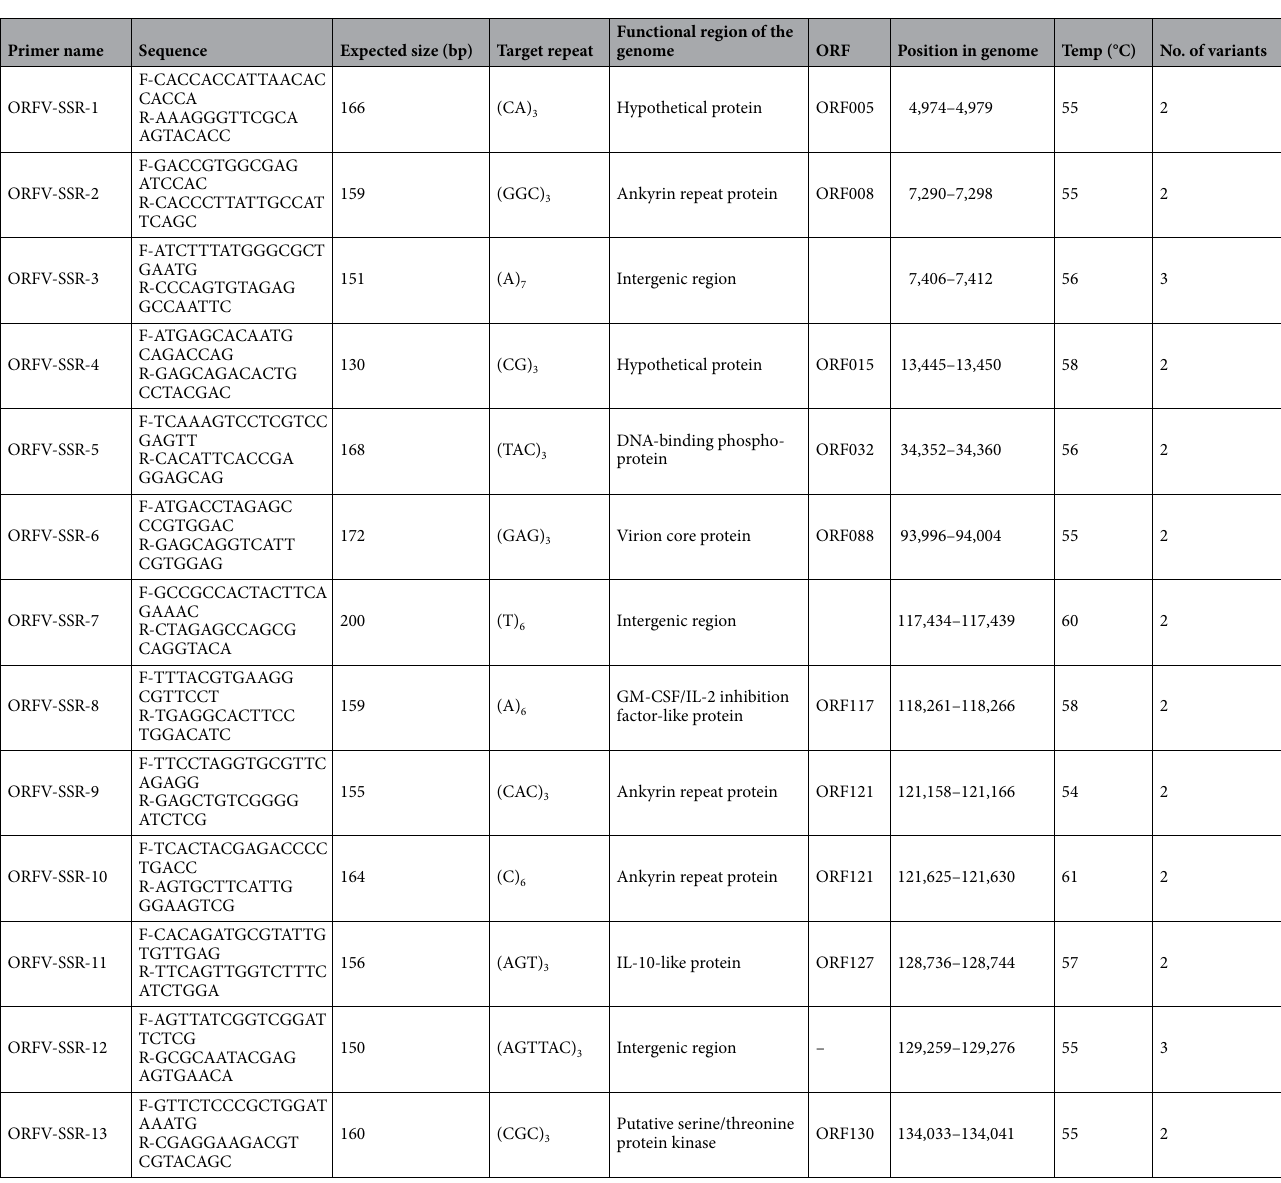
Table 2. Characteristics of the 13 microsatellite markers developed for the